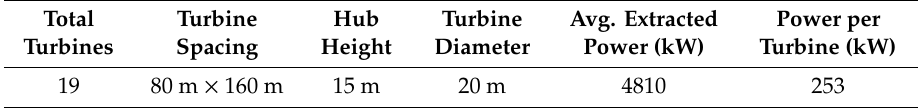
Table 6. Tidal turbine configuration and simulated extractable power in the Western